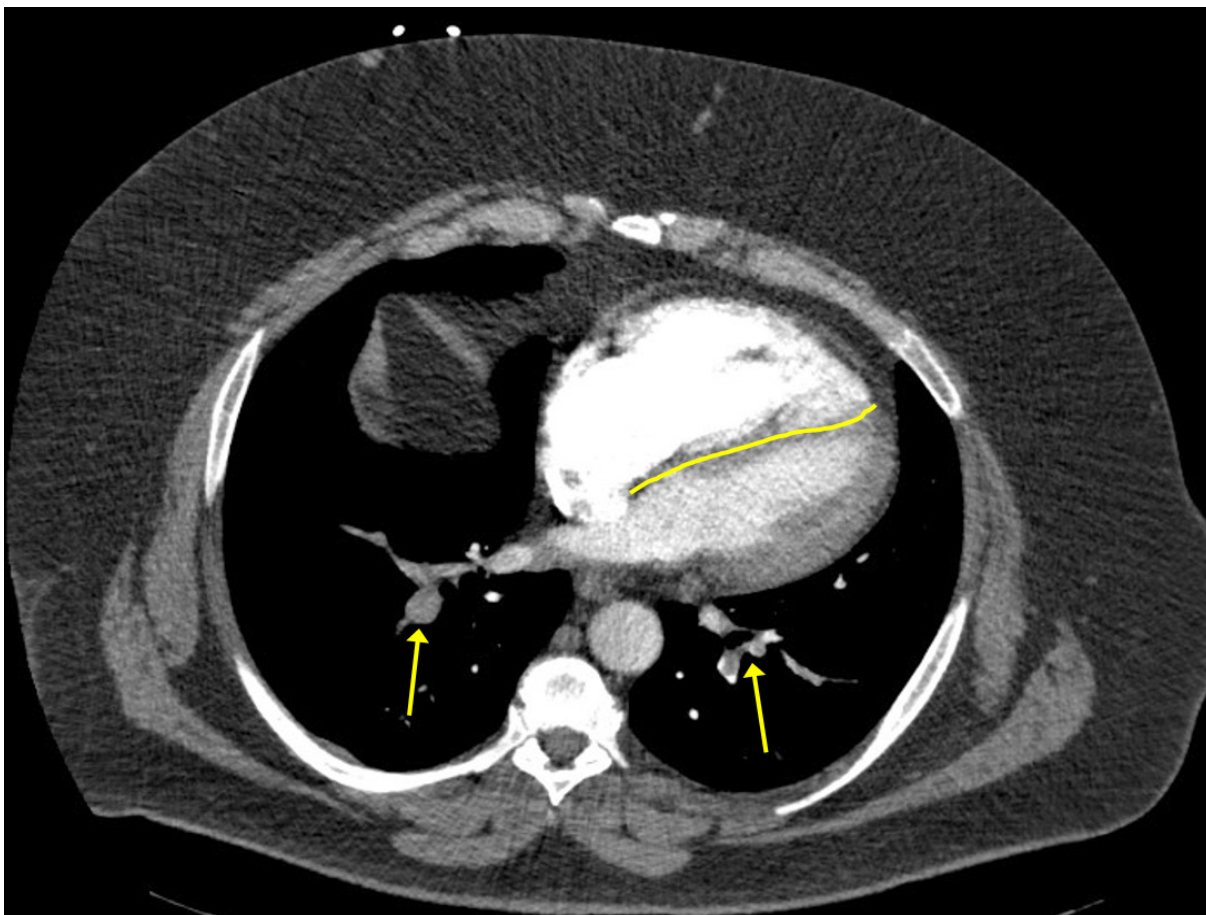
Image 2. Additional view of the computed tomography pulmonary angiogram demonstrating occlusive and nonocclusive lower lobe pulmonary artery emboli bilaterally (yellow arrows). Straightening and leftward bowing (yellow line) of the interventricular septum indicating right-sided heart strain is also